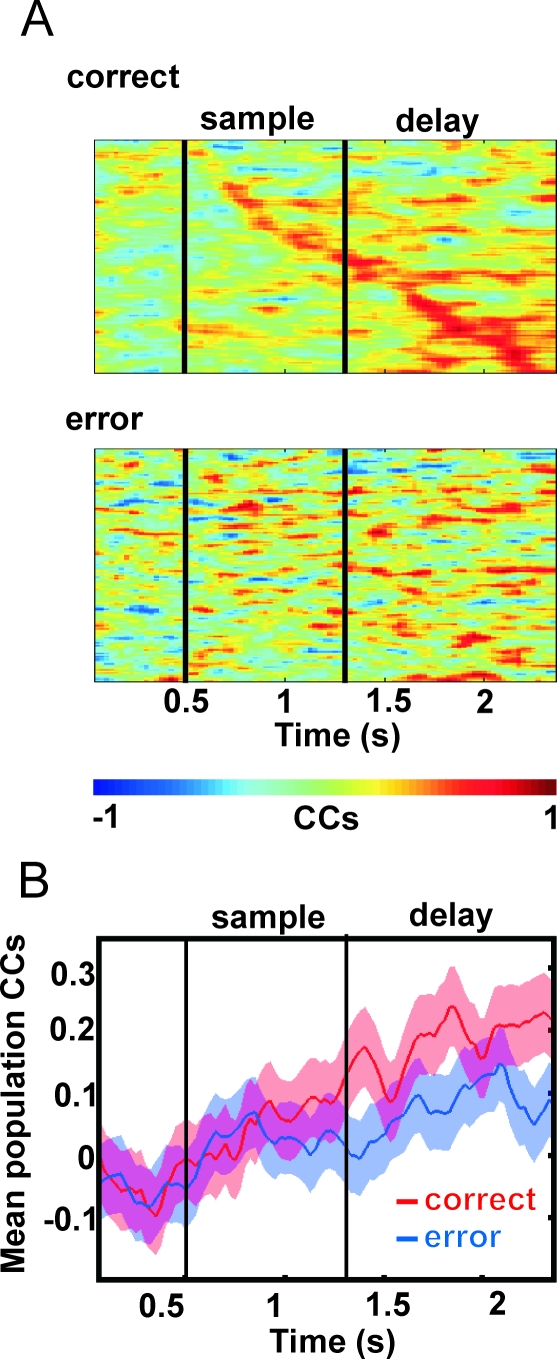
Error Trial Analysis for PFC Neurons(A) Temporal profile of CCs during correct trials (upper panel) and error trials (bottom panel) for the same association neurons (running average rectangular filter, window size five data points). Neurons are sorted by time of maximal correlation.(B) Time course of mean CCs across cells for correct and error trials (running average rectangular filter, window size five data points; shaded areas ± standard error of the mean).